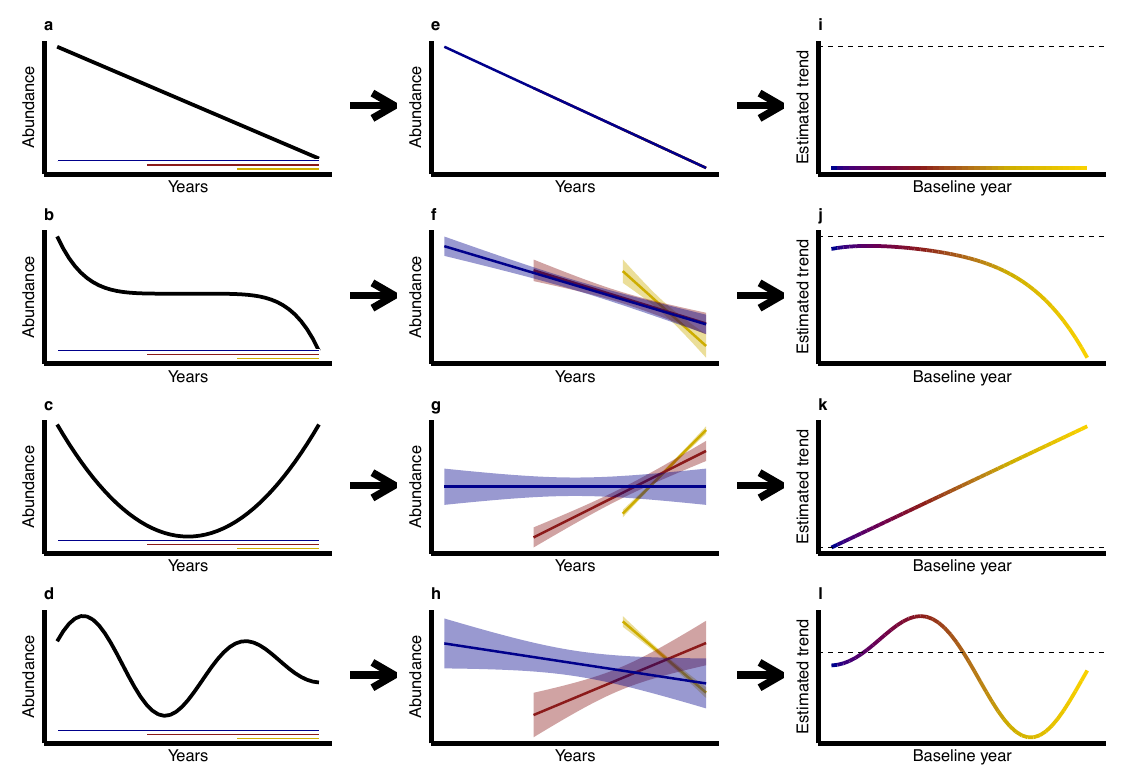
Figure 1: Schematic examples of how baseline year may affect estimated linear abundance trends . (a-d) Hypothetical time-series showing abundance variations over years (black) and three possible temporal coverages with contrasting baseline years: old (blue), intermediate (red) and recent (yellow). (e- h) Linear abundance trends estimated with time series starting from these three baseline years. (i-l) Pattern of estimated abundance trends against baseline year, reconstructed by estimating abundance trends over all possible baseline years. The dashed black line shows the zero-value delimiting positive (above) vs. negative (below) abundance